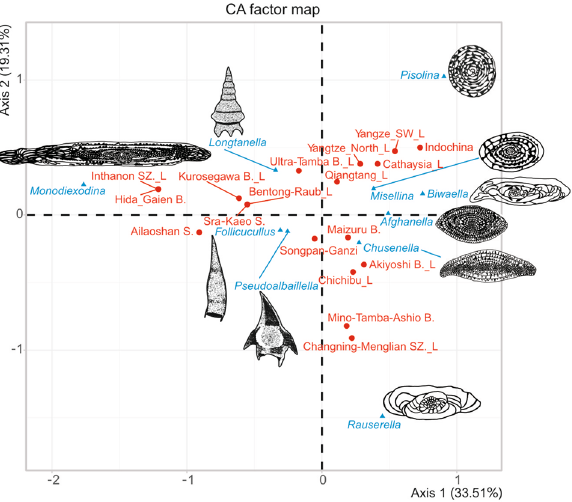
Figure 4. Correspondence plot of CA applied to the occurrences of selected radiolarian and fusulinid genera. Abbreviations: B., Belt; S., Suture; SZ., Suture Zone; L, indicates the presence of Longtanella . N.S. created this figure using R version 3.3.2 (https:// www.r- proje ct. org/) and Y.F.X. revised this figure using CorelDRAW X4.